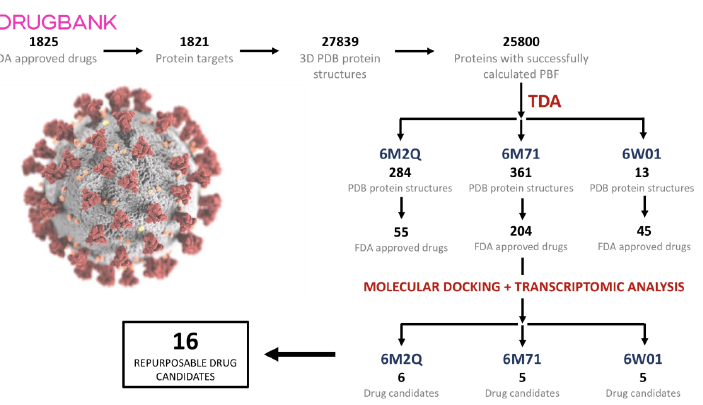
Figure 2. Schematization of the narrowing-down process followed to identify the final 16 drug candidates. Table 2. Drug repurposing candidates based on the topological, trascriptomic, and docking criteria. PC: Pearson correla- tion. LE: Lowest energy conformation in the cluster. Candidates with a PC of <−0.1 may revert the transcriptomic effects of SARS-CoV-2 infection. The maximum number of the AutoDock cluster is 150. Drug ID (colum 2) encodes the DrugBank ID of the corresponding drug (column 1).